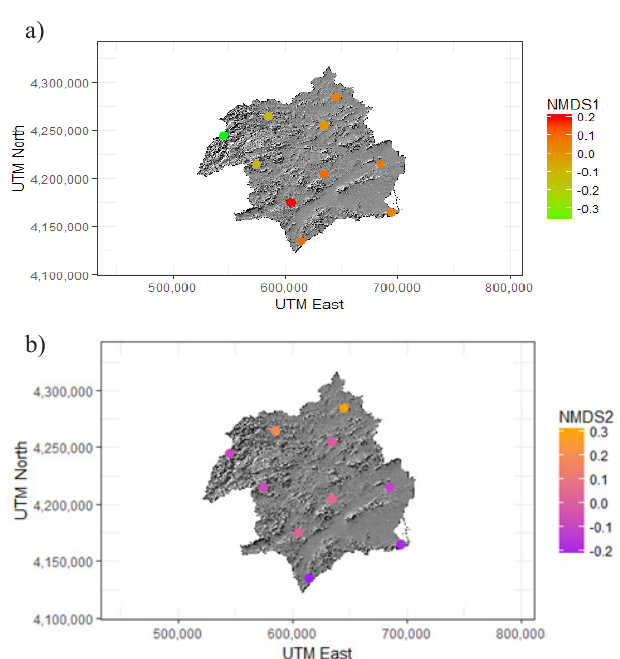
Fig 4 . Geographical representation of coordinates of 10×10 km UTM squares of the systematic sampling (see Methods) on NMDS space of Figure 3. (a) Coordinates on axis NMDS1. (b) Coordinates on axis